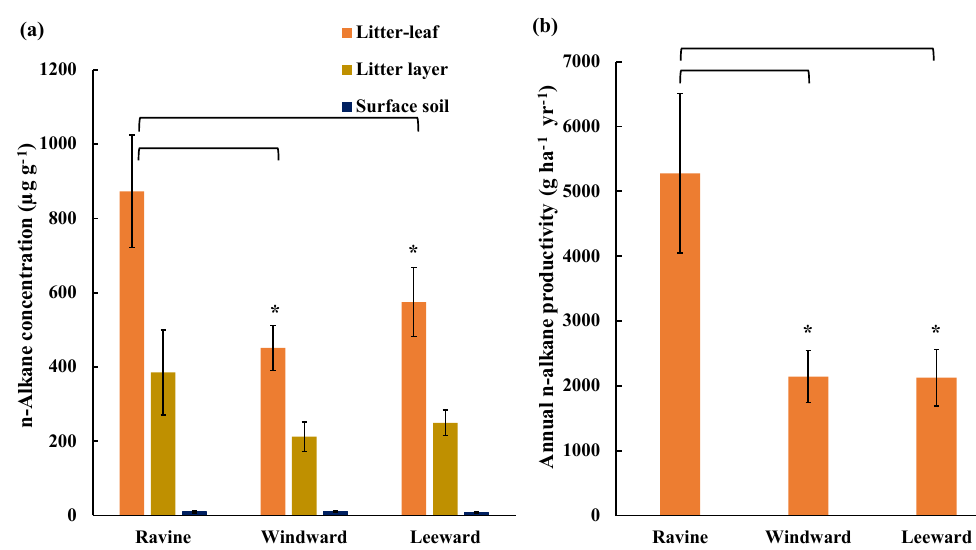
Figure 2. (a) n -Alkane concentration in litter-leaf, litter layer, and surface soil. n -Alkane concentration in litter-leaf was higher in the ravine habitat than in the other two habitats (* p <0.05). (b) Estimated annual n -alkane productivity generated by litter-leaf of litterfall in three habitats (* p <0.05).